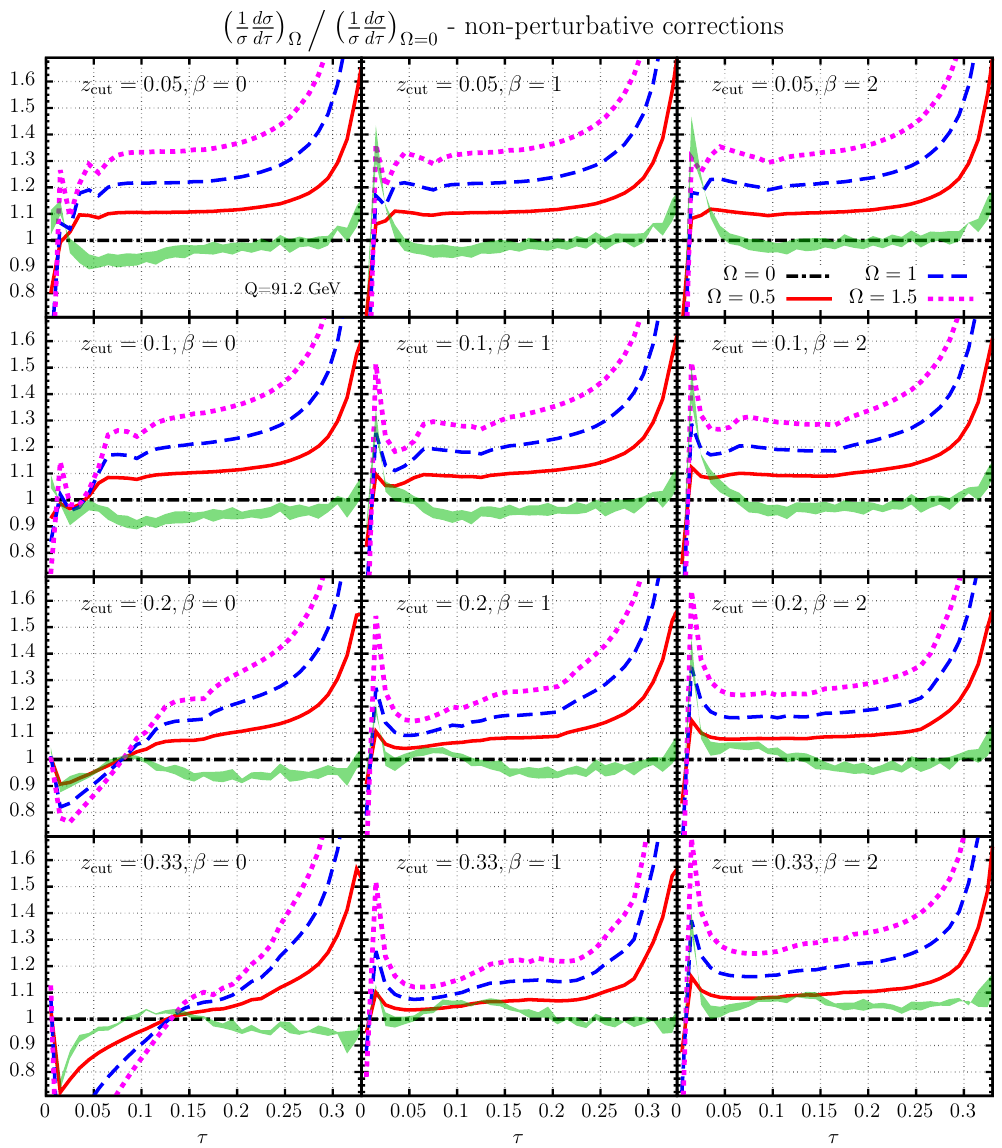
Figure 5. Ratios for the soft-drop thrust NLO+NLL cross section under variation of the analytical hadronisation parameter (cid:10) with respect to no non-perturbative corrections, i.e. (cid:10) = 0 GeV. Where the green band shows the hadron to parton level ratio for